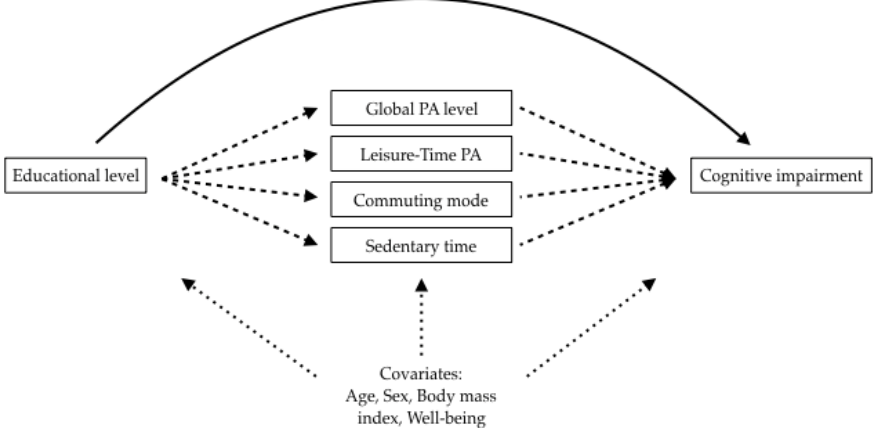
Figure 1. Causal diagram of the mediation hypothesis. The solid arrow line displays the natural direct effect pathway and the arrows with dashed lines display the natural indirect pathway. The three-pointed arrow lines display the confounding variables. PA: physical activity.